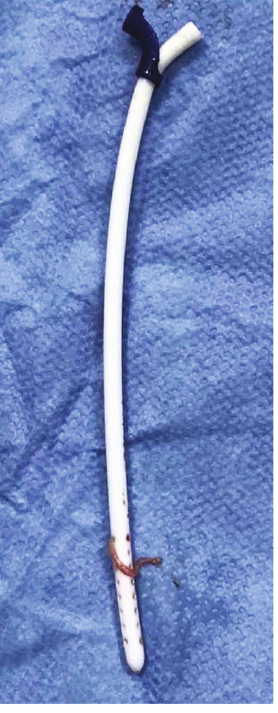
Figure 4: The previous ventricular catheter after removal. This fi gure demonstrates the choroid plexus adhesions around the original